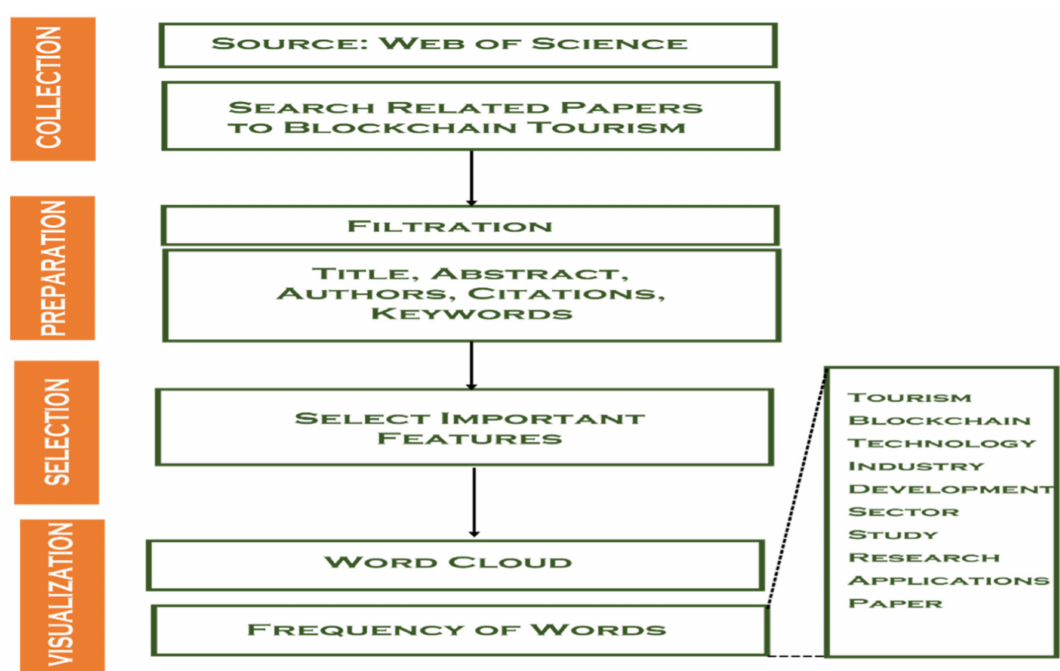
Figure 2. Architecture of proposed methodology. Source: Authors’ conception.